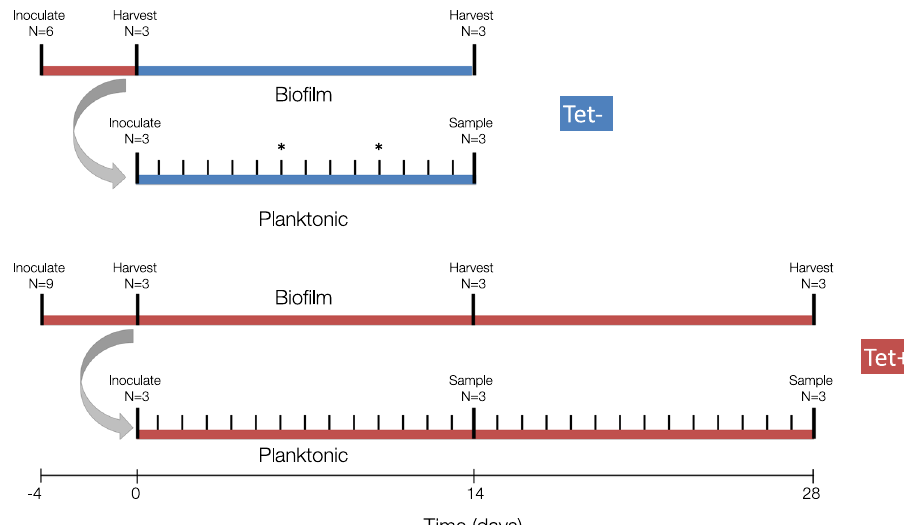
Fig. 1 Timeline of the evolution experiments. Red represents time periods when media contained tetracycline (Tet + treatment); blue represents the absence of antibiotics (Tet − treatment). Large ticks represent inoculation and harvest/sampling events. Four days prior to the initiation of the evolution experiments ( − 4), the bio fi lm fl ow cells were inoculated with the ancestral strain. Four days later, at day 0 ( t 0 ), the fi rst set of randomly selected fl ow cells ( n = 3) was harvested. A subsample of the cell suspensions from each of these replicates was used to inoculate each of the three planktonic populations (gray curved arrow). Small tick marks indicate the daily serial passage of planktonic populations. Asterisks on days 6 and 10 in the timeline of the Tet − planktonic populations indicate the last day at which plasmid-containing cells were detected in two of the three populations due to rapid plasmid loss; these time points were the fi nal sampling points for these two populations ( t 6 and t 10 ). The Tet − experiment was terminated after 14 days, and the Tet + experiment after 28. For more details on the actual protocol, see Materials and Methods and Ridenhour et al. 43